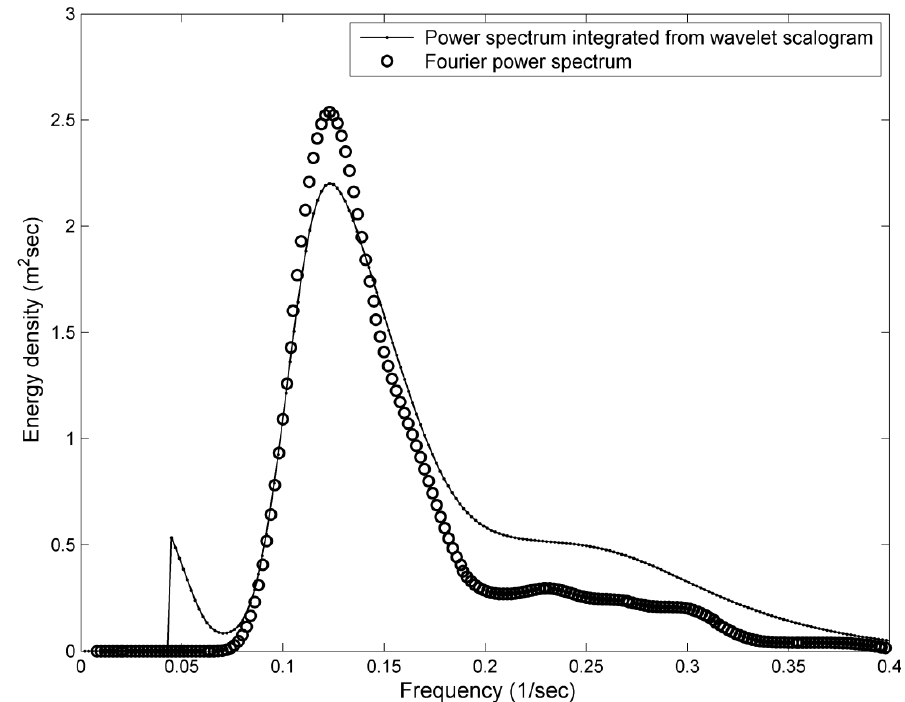
Figure 11. A comparison between a wave spectrum derived by Fourier transform and a time-averaged wavelet spectrum derived by wavelet